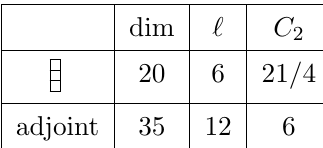
Table 1 . The table of the number of dimensions dim, the Dynkin index ‘ and the quadratic Casimir C 2 of the representations and adjoint. We observe that these quantities of the adjoint representation are larger than those of the